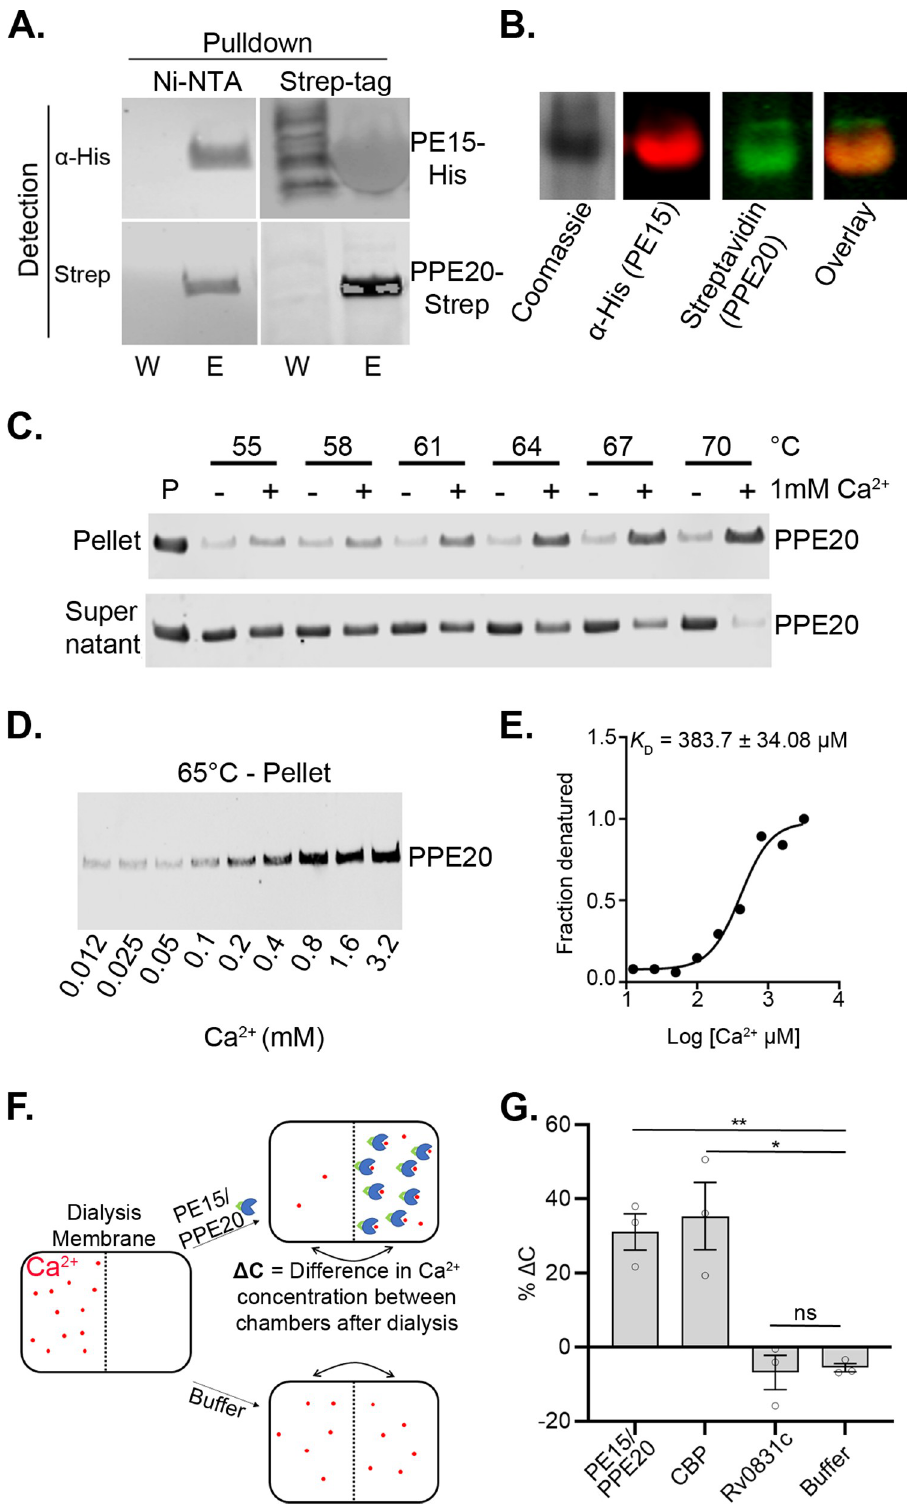
Fig 2. PE15 and PPE20 form a complex and PPE20 binds Ca 2+ . (A) Western blot of PE15 with an N-terminal His tag and PPE20 with a C-terminal Strep tag shows the 2 co-purify. W: wash, E: elution. (B) PE15 and PPE20 co-migrate on a native PAGE gel, also indicating complex formation. (C) Thermal shift experiment with western blot